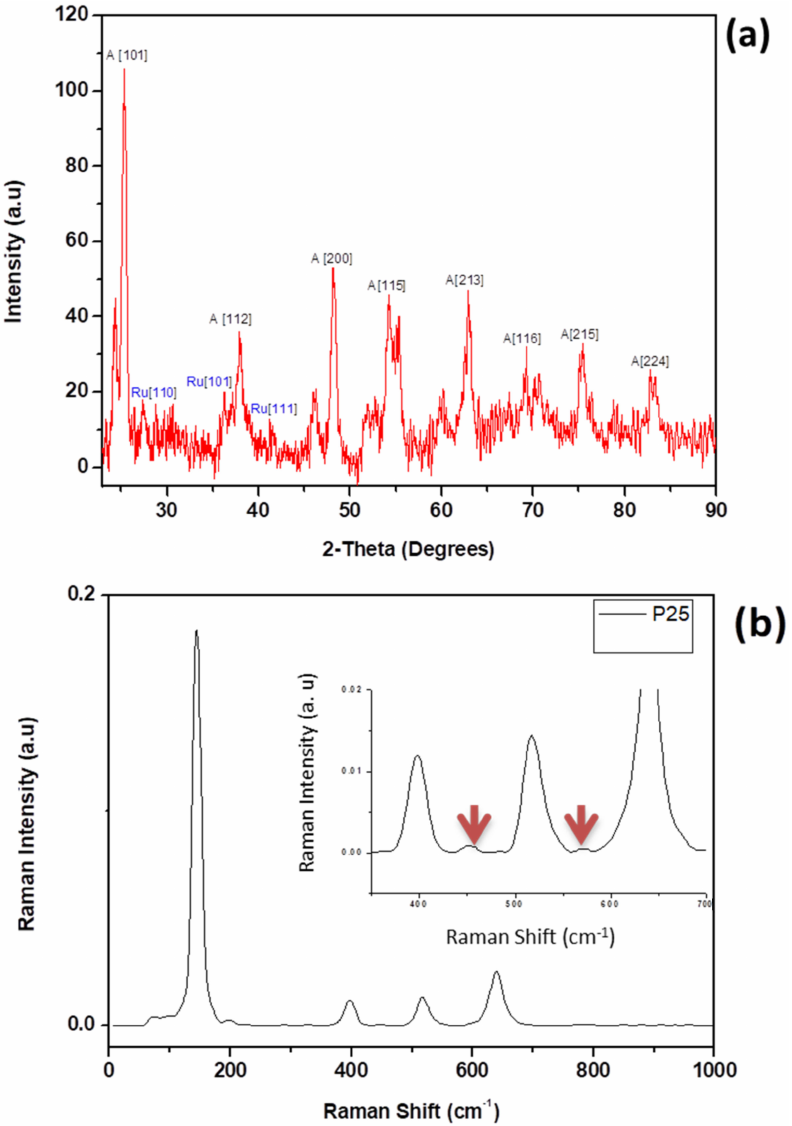
Figure 5. The ( a ) XRD and ( b ) Raman spectra of titanium oxide nanoparticles with the arrows showing the rutile